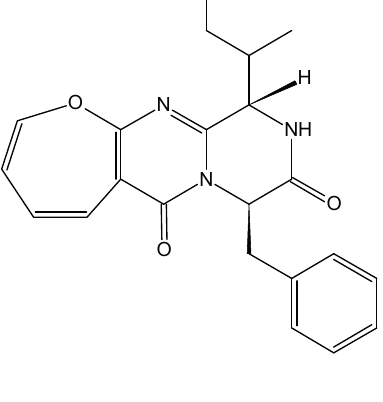
Figure 22. Protuboxepin